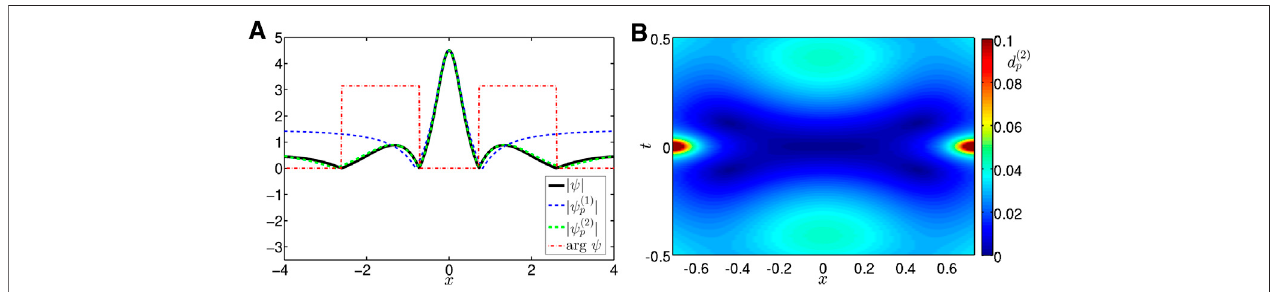
FIGURE 3 | ( Color on-line ) Synchronized three-soliton interaction of solitons having amplitudes a 1 (cid:2) 1, a 2 (cid:2) 1 . 5 and a 3 (cid:2) 2, zero velocities v j (cid:2) 0, zero space positionsparameters x 0 j (cid:2) 0and,attheinitialtime t (cid:2) 0,zerophases Θ j (cid:2) 0: (A) spacepro fi le and (B) relativedeviation Eq.6 betweenthewave fi eldandthe fi twiththeRBS2inthe ( x , t ) -plane.Allnotationsarethesameasin Figures1A,D .Thedeviation Eq.7 from the RBS2 fi t equals to D ( 2 ) p ≈ 0 .